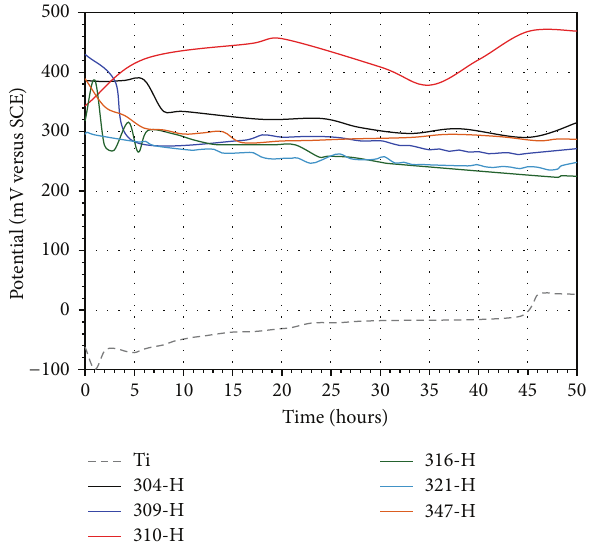
Figure 9: 𝐸 values after testing time for materials in mouthwash corr solution at 37 ∘